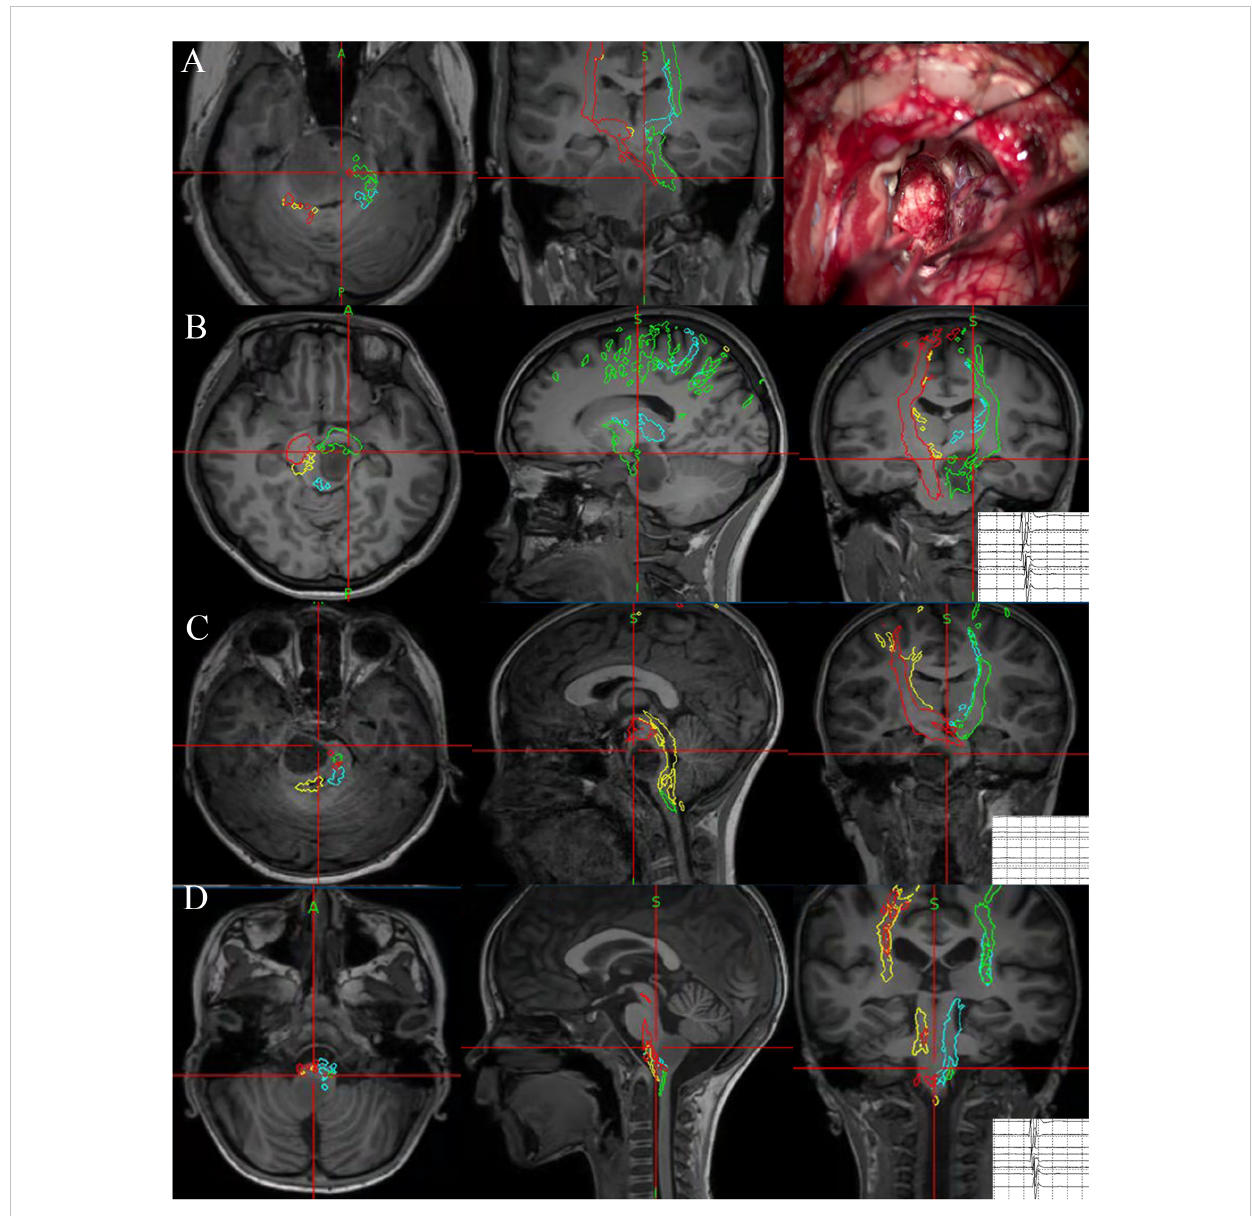
FIGURE 1 Illustration of four cases that underwent NN-guided surgery for BSG. NN indicated the cytoreductive surgery in DIPG. The predetermined surgical boundaries located near the CST were reached under navigation guidance. During operation, neurophysiological monitoring lost its value because the CST was severely disrupted preoperatively (A) . A focal glioma located in midbrains. NN indicated the current position was near CST and thus EOR was reached, and neurophysiological monitoring also reported CST located near the current position (B) . A focal glioma located in pontine. NN indicated the position was near the imaging boundary of a tumor in the pons, and neurophysiological monitoring could not indicate the nearest CST as there is a distance between current position and the nearest CST (C) . A focal glioma located in medulla oblongata. NN indicated the position was near the imaging boundary of a tumor in the medulla, neurophysiological monitoring also reported CST located near the current position (D)